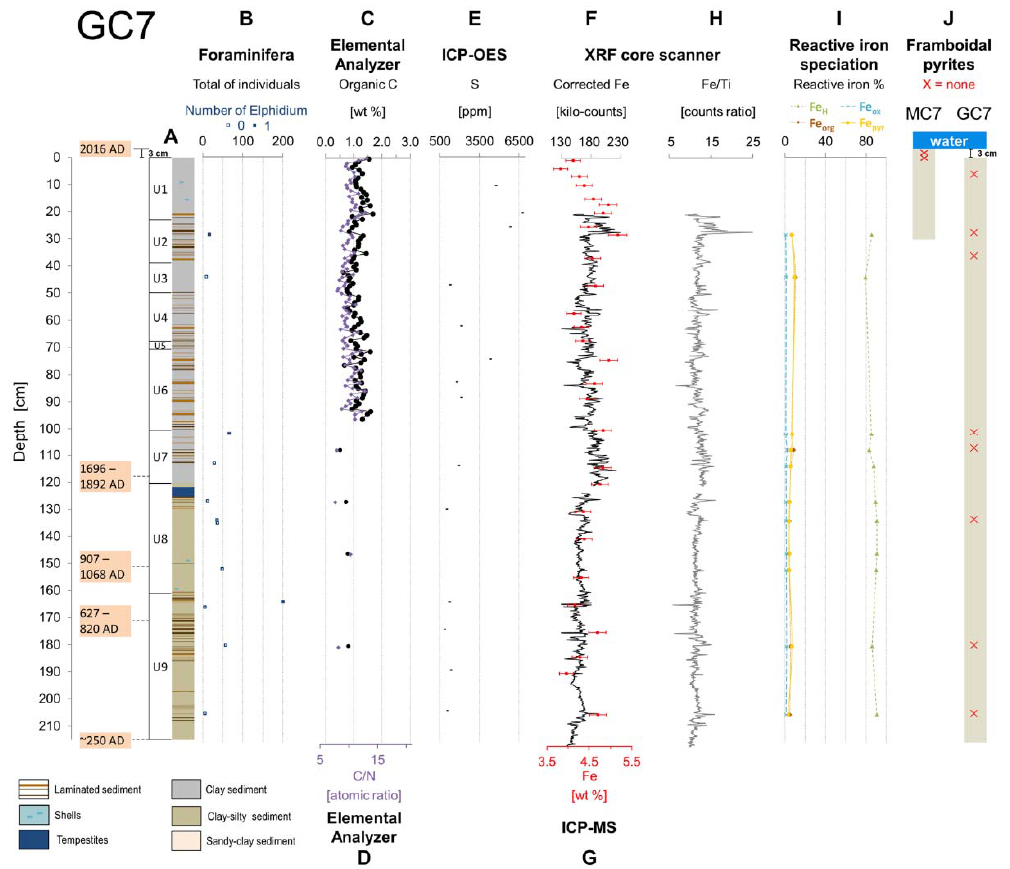
Figure 6. Results of selected proxies for the GC7 core: ( A ) laminations in most of the core (macroscopic observations, SCOPIX and thin sections); ( B ) relatively low number of benthic foraminifera, including no or only one Elphidium individual; ( C ) slight decrease with depth of organic carbon content (mean = 1.1 wt % C) and ( D ) C/N atomic ratio (Elemental Analyser); ( E ) relatively low total S concentration (ppm, error bar smaller than symbol) measured with ICP-OES compared to GC15; ( F ) corrected kilocounts of Fe (XRF core scanner) showing no correlation with ( G ) the total Fe concentration measured by ICP-MS (wt %, with the error bar); ( H ) Fe/Ti (XRF core scanner) variations; ( I ) homogeneous reactive iron speciation with ~80% of Fe H (FeS, siderite, ferrihydrite, akaganeite and lepidocrocite) and low abundance of Fe org (iron bound to organic matter), Fe ox (hematite and goethite) and Fe pyr (pyrite); ( J ) no framboidal pyrites observed (SEM) nor in the 0–2 and 2–4 cm of MC7, neither in several samples from GC7 (0 cm on the scale on the left, i.e., top of GC7, does not correspond to the water-sediment